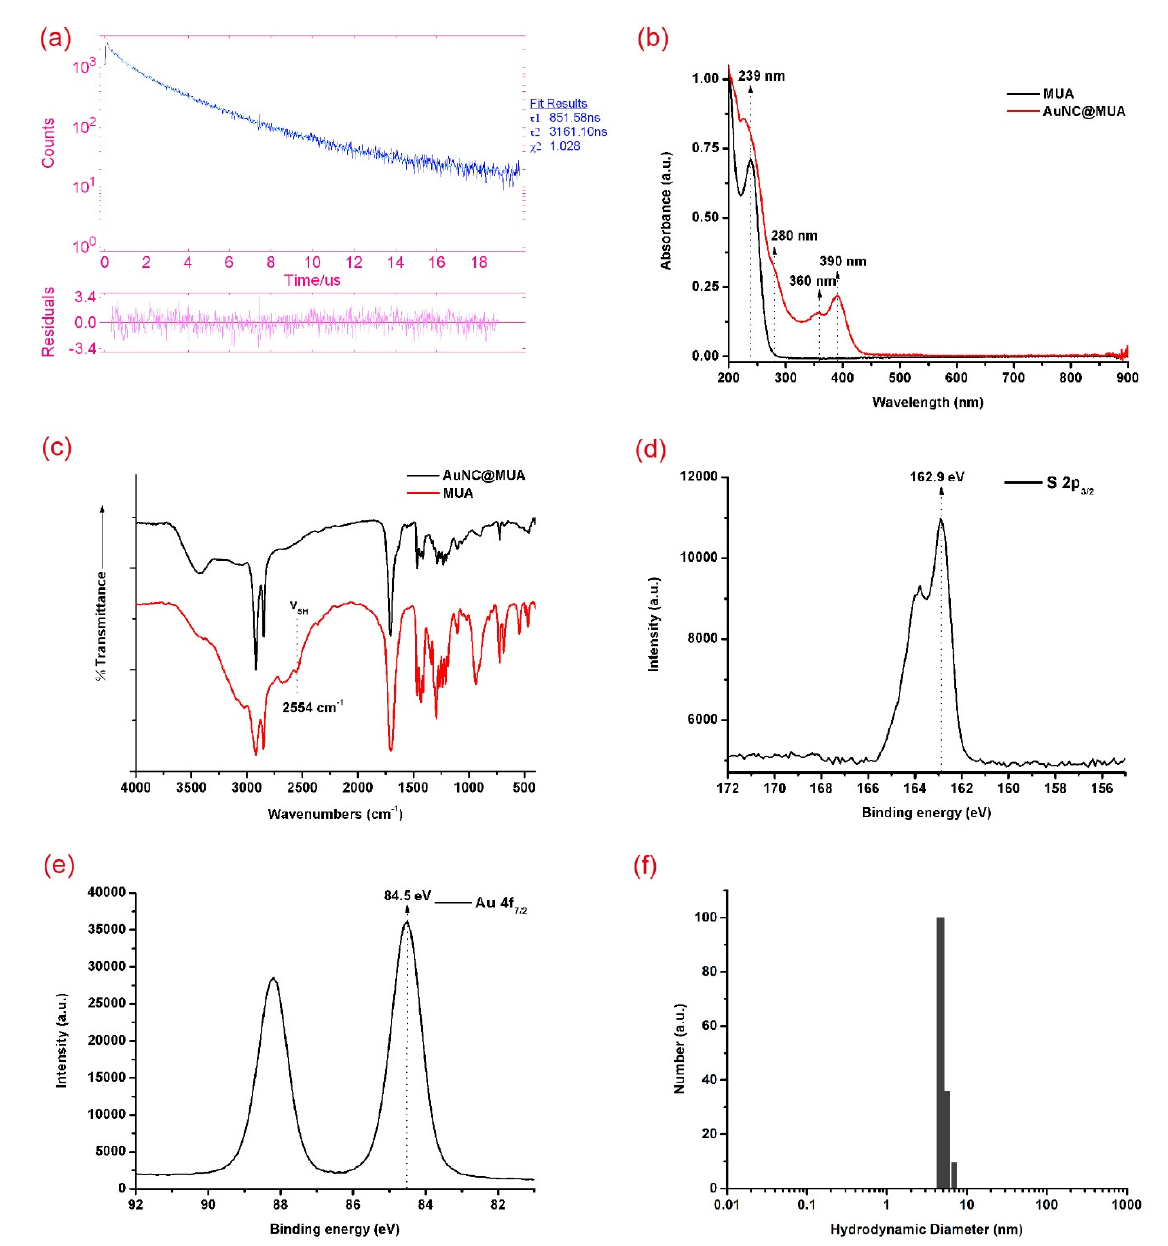
Figure 2. ( a ) PL lifetimes of as-synthesized AuNC@MUA; ( b ) UV-Vis absorption; ( c ) Fourier transform infrared spectra of MUA and AuNC@MUA; ( d ) S 2p; ( e ) Au 4f spectra; ( f ) dynamic light scattering of AuNC@MUA.